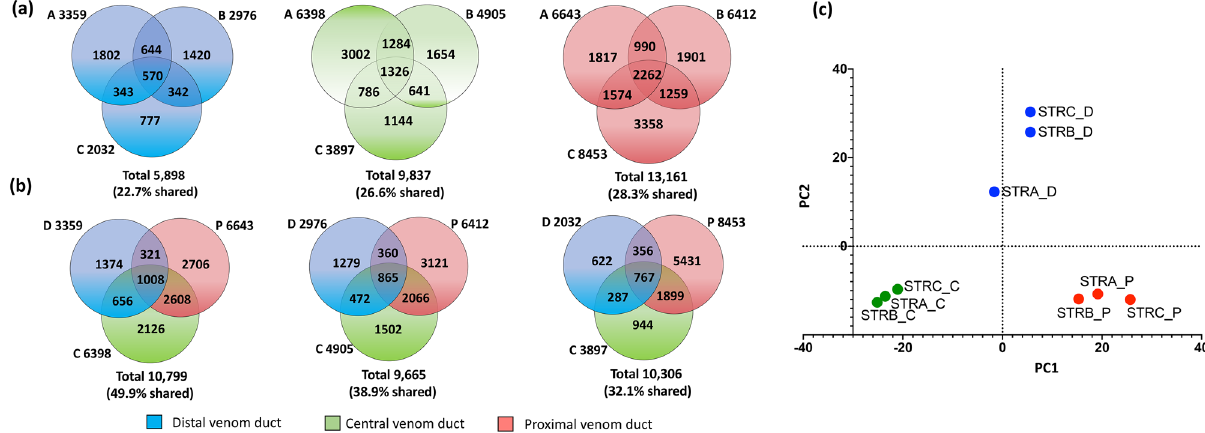
Figure 4. Comparison of the peptide distribution in three venom duct sections (distal, central and proximal) across the three adult C. striatus (specimens A–C). (a) Venn diagrams showing the common and unique peptide masses across the three venom duct sections (D, C and P) in three specimens (A, B and C) of C. striatus. Total mass units detected in the LC–MS for each specimen is shown below the respective Venn diagram. (b) Venn diagrams showing the mass variability in each venom duct section (D, C and P) across the three specimens (A, B and C) of C. striatus. Percentage of the shared masses between the specimens are shown under the each Venn diagram. (c) PCA plot showing the variability of the venom extracted from dissected venom duct sections in three specimens. LC–MS data generated from SCIEX 5600 QTOF instrument is statistically analysed using the MarkerView software to obtain the PCA and loading